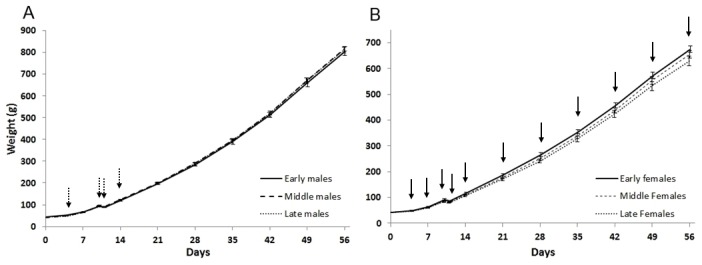
Weight development of a) males (N = 30) and b) females (N = 30) over the experiment.The graphs show mean±S.E for each hatch group. The solid line arrows indicate significant correlation (p<0.05) between hatch time and weight, whereas the dashed arrows indicate tendency (p<0.1).